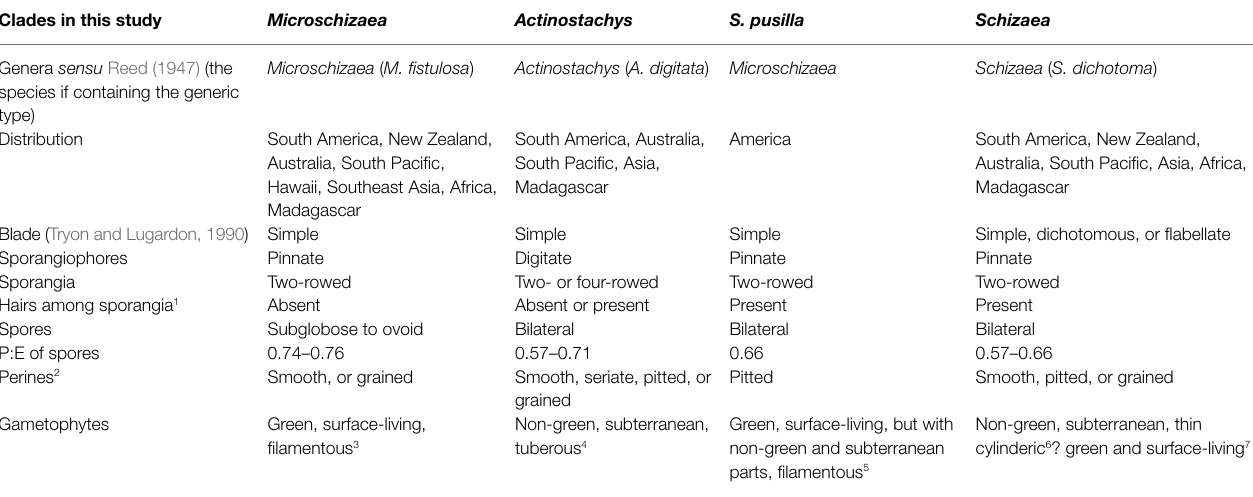
TABLE 1 | Morphological comparison between the clades and genera of Schizaeaceae. Clades in this study Genera sensu Reed (1947) (the species if containing the generic